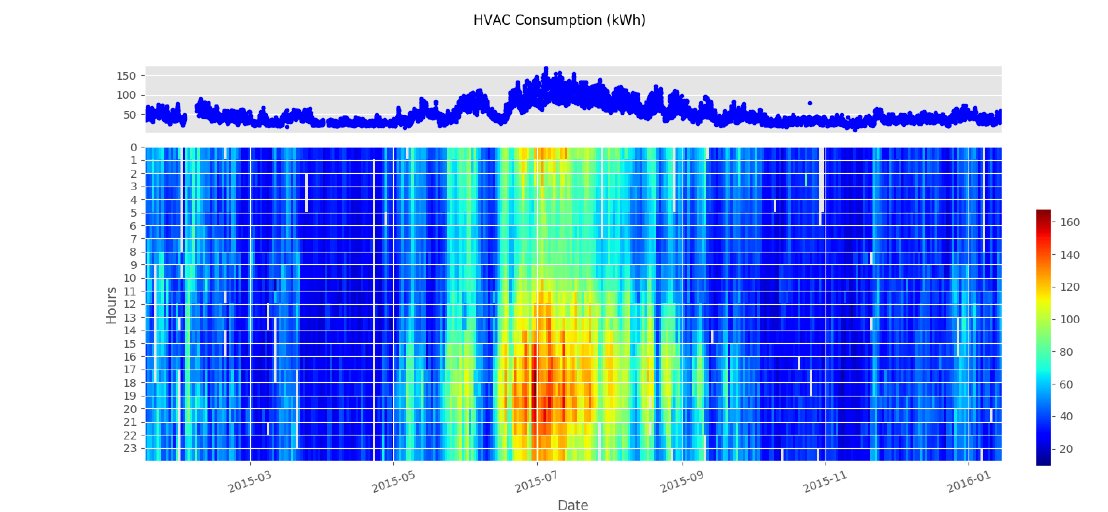
Figure 3. Actual hourly HVAC energy consumption. The data shown in the figure is from 15 January 2015 to 15 January